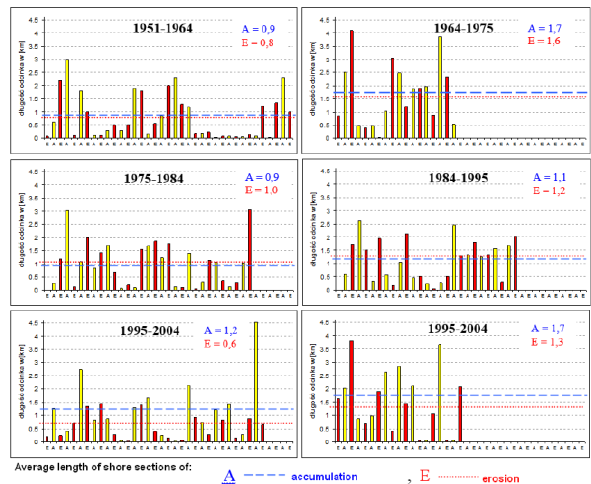
Figure 3. Charts showing the length of particular shore sections [km] of accumulation and of erosion types in successive time periods in the examined part of Baltic Sea coast